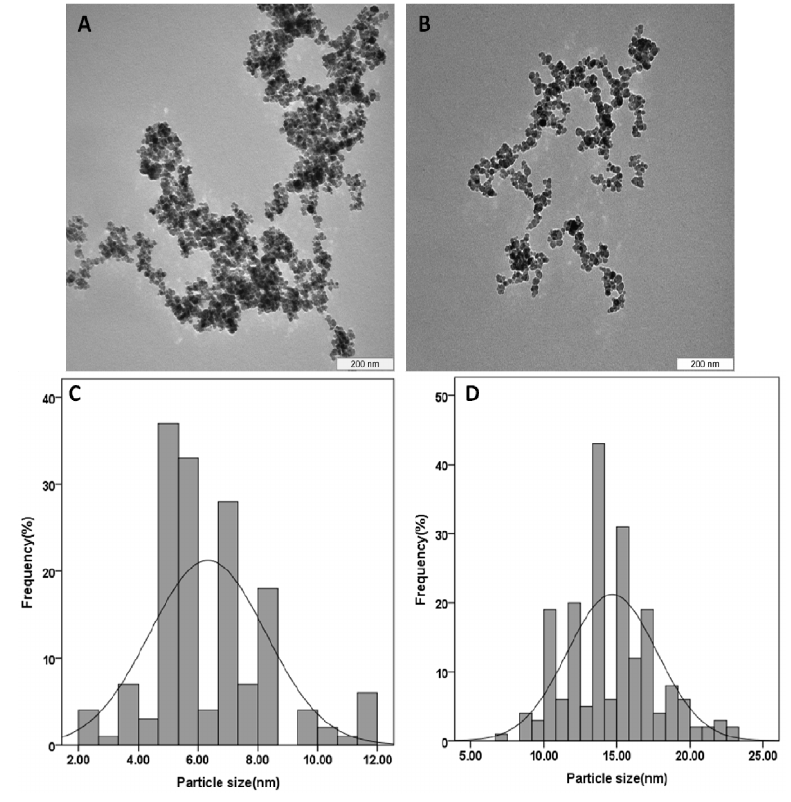
Figure 5. TEM micrographs ( A ) iron oxide magnetic nanoparticles with 200 nm microbar; ( B ) iron oxide nanoparticles coated with chitosan-prindopril erbumine (FCPE)